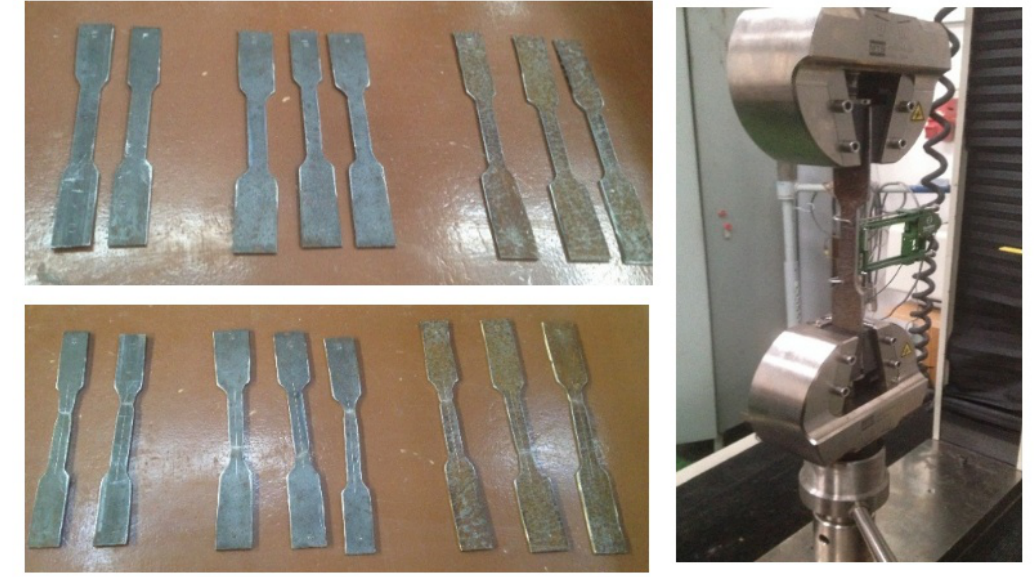
Figure 4. Coupon tests specimens and scheme of loading.